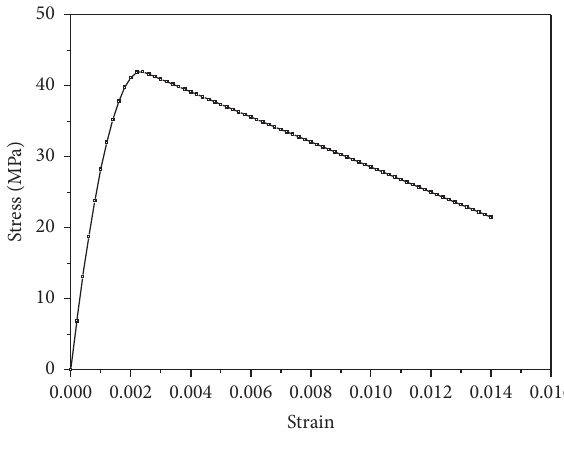
Figure 7: Stress-strain curve for confined concrete. Table 3: ABAQUS input values for confined concrete. Plastic stress (MPa)